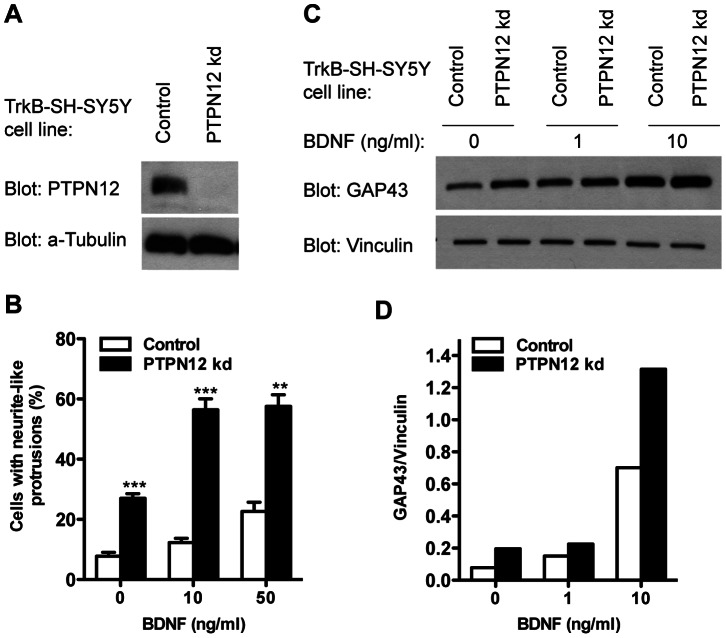
PTPN12 decreases neurite-like outgrowth in TrkB-SH-SY5Y cells.A) Western blot analysis of PTPN12 expression level in TrkB-SH-SY5Y cells stably expressing a pGIPZ shRNAmir non-targeting PTPN12 (PTPN12 kd) or the non-silencing control. α-Tubulin is used as reference. B) Neurite-like outgrowth in PTPN12 kd cells compared to the control. Cells were seeded at low density and grown for 24 h before stimulation with BDNF as indicated for 3 days in serum-free medium. Cells were then stained with a β-III-Tubulin antibody and Hoechst 33342 and pictures were acquired and analyzed automatically. Data shown are mean and S.E.M. of triplicates and are representative of two independent experiments. Statistical analysis was performed using Student’s t-test comparing PTPN12 kd and control cells for each BDNF concentration (**: p≤0.01; ***: p≤0.001). C) Western blot analysis of cells treated as in B) for GAP43 expression using Vinculin as loading reference. D) Densitometric quantification of the results in C).